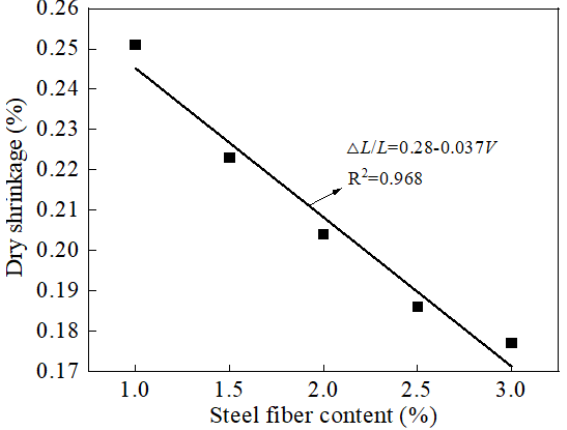
Figure 12. The shrinkage rate of reactive powder concrete.